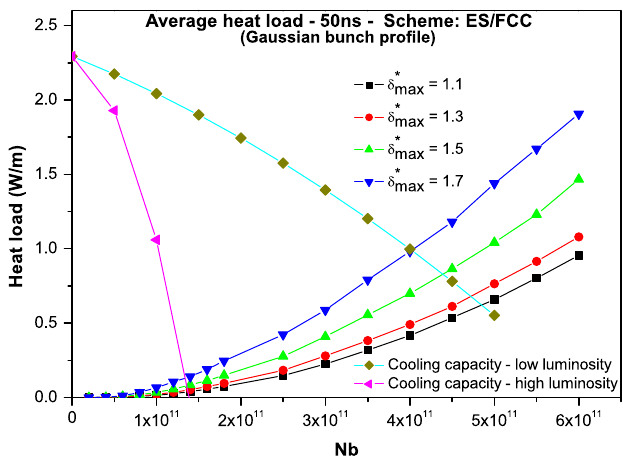
FIG. 11. Average heat load for the simulation set C.